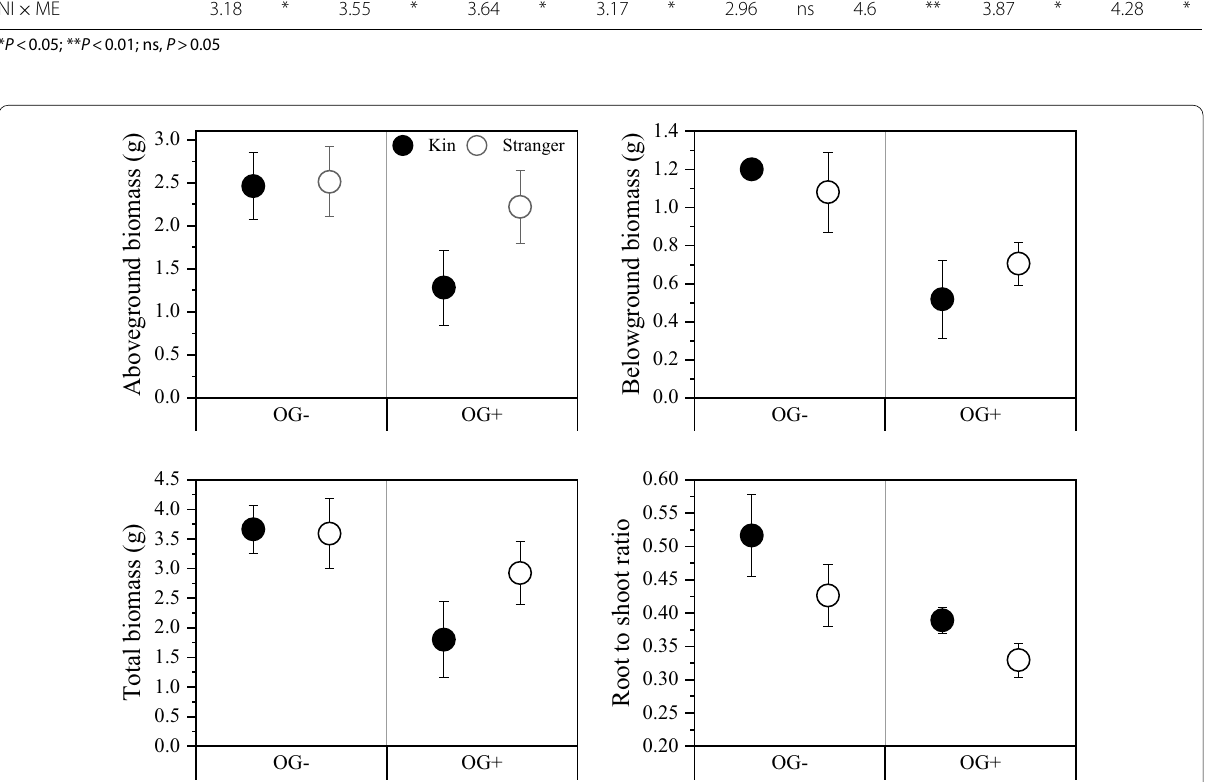
grown with stranger neighbors and a lower root bio- mass allocation when grown with kin neighbors (Addi- tional file 1: Fig. S2). Compared with kin, the tiller number of non-grazed offspring increased by 73.08%, whereas grazed offspring increased by 8.00% when grown with stranger neighbor (Additional file 1: Fig. S3). LRRs of biomass per offspring were significantly reversed from negative to positive by grazing-induced maternal effect (Fig. 4b). Compared to the offspring